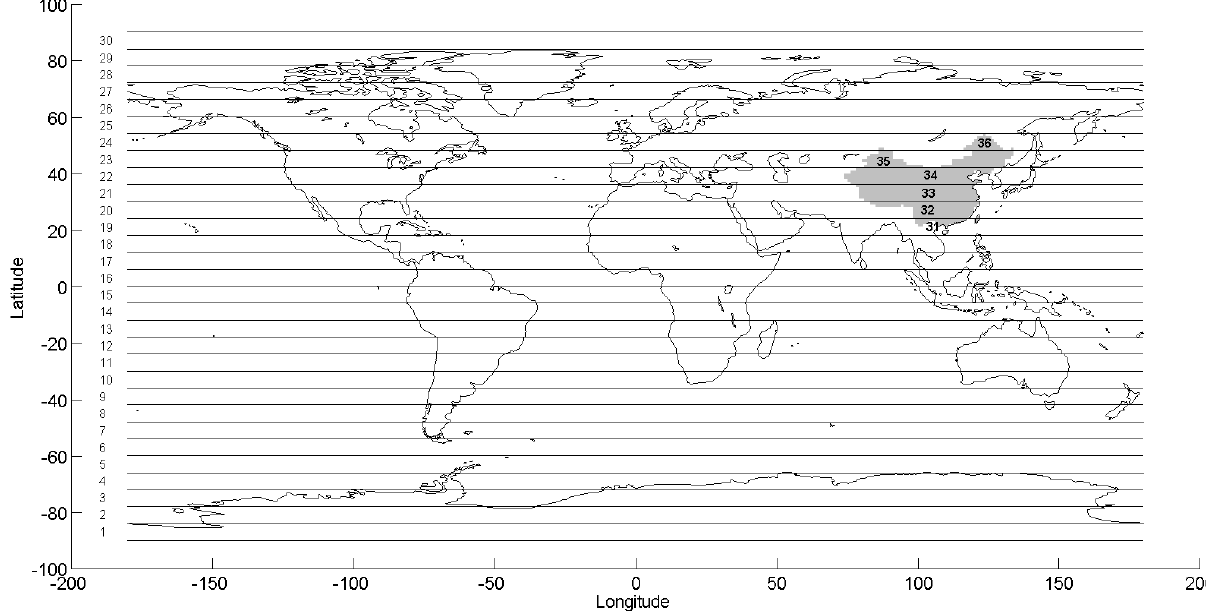
Figure 2. The partition the globe into zones.